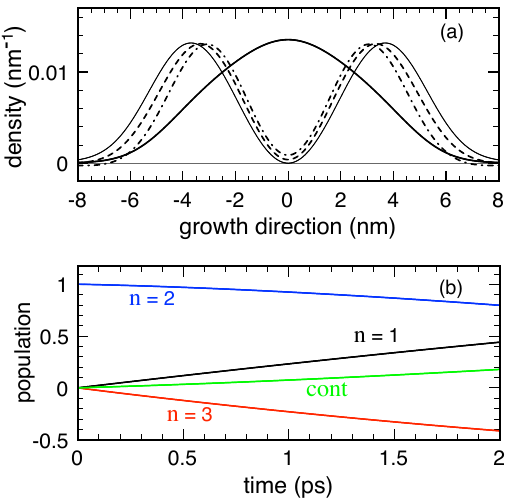
Figure 6. Low-temperature and low-density dissipation dynamics in the 12nm thick GaAs/AlGaAs QW of Figure 3 resulting from the fully 3D local Boltzmann model in Equation (10) in the low-density limit. ( a ) Carrier density n ( z ) in Equation (19) as a function of position at different times: 0ps (thin solid curve), 0.8ps (dashed curve), and 1.6ps (dash-dotted curve); the equilibrium carrier density is also shown for comparison (solid curve). ( b ) Bound-state subband populations [see Equation (20)] as well as continuum (cont) contribution as a function of time. Reprinted from